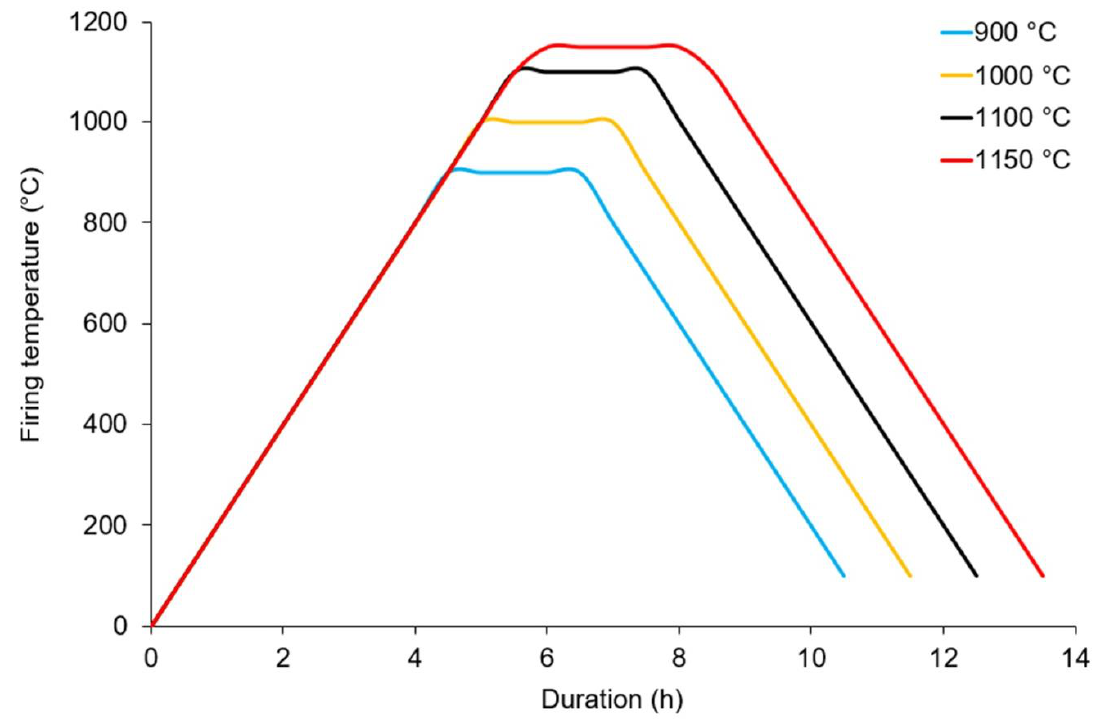
Figure 2. Temperature profiles used for brick firing.